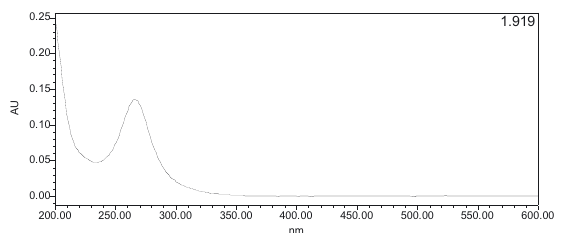
Figure 9. Chromatography spectrum of KGN after 2 h of irradiation with